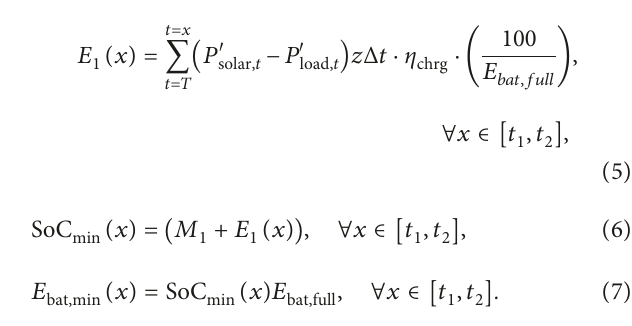
Figure 2: Time periods